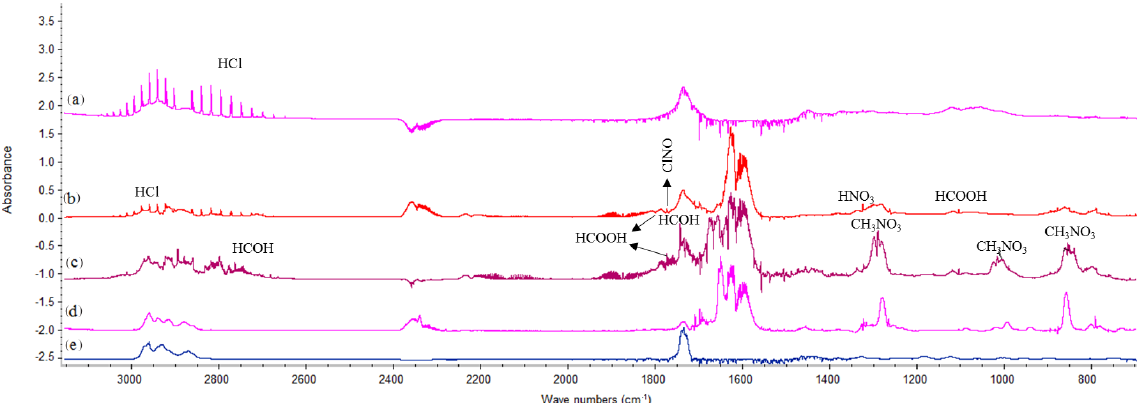
Figure 2. Product spectra for the reaction of 4MCHexOH with (a) chlorine atoms at 10min ( × 2 for clarity), (b) Cl atoms in the presence of NO x at 7min, (c) the OH radical at 40min, and (d) the NO 3 radical at 32min. (e) Spectrum of the 4-methylcyclohexanone commercial sample.